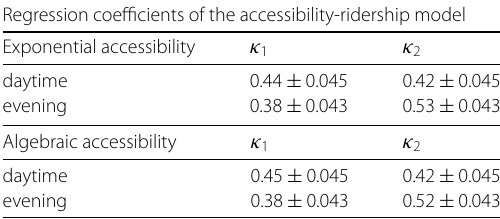
Table 3 Regression coefficients κ 1 and κ 2 in the accessibility-ridership model given by Eq. (8) for exponential accessibility and algebraic